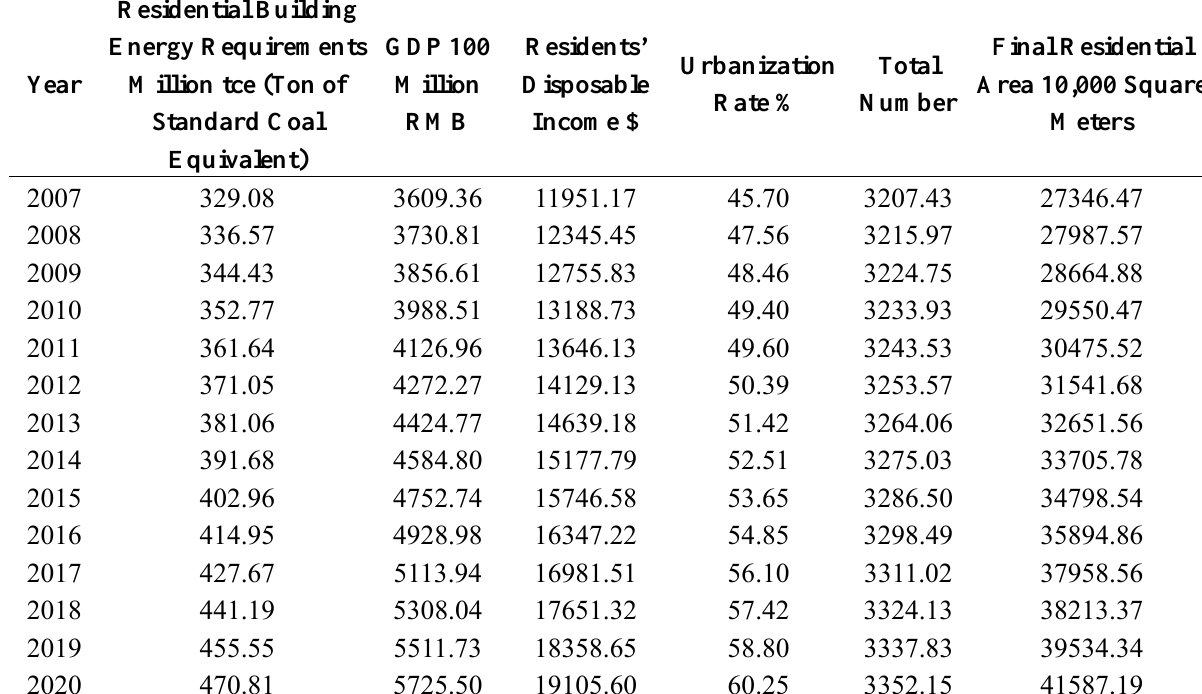
Table 3. Chongqing residential building energy